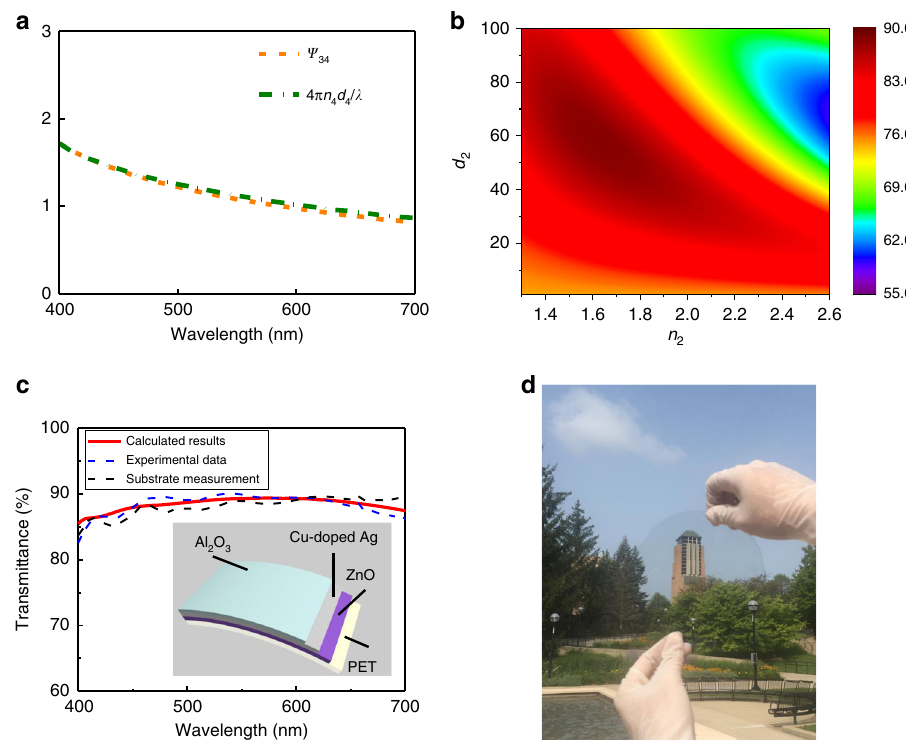
Fig. 4 Experimental demonstration of the designed DMD electrode. a The calculated values of the left and right terms in Eq. (9) when using 24 nm ZnO and 6.5 nm Cu-doped Ag as Dielectric 2 and the metallic layer, respectively, in the DMD structure. It shows Eq. (9) is well satis fi ed across the entire visible range. b Averaged absolute visible transmittance (%) of the DMD electrode dependent on the refractive index and the thickness of the top dielectric (Dielectric 1) when Dielectric 2 and the metallic layer are selected as 24 nm ZnO and 6.5 nm Cu-doped Ag, respectively. c Calculated (red solid curve) and measured (blue dashed curve) absolute transmittance from 400 to 700 nm of the designed DMD transparent electrode, showing great consistency with each other. The representative measured spectrum with an averaged transmittance of ~88.4% is taken from the measurement results of 15 samples. As a comparison, one representative transmittance spectrum of the bare PET substrate with the averaged transmittance of ~88.1% is provided to show how the optical performance of the optimized DMD electrode gets improved. Inset presents the con fi guration of the designed DMD electrode, i.e., PET